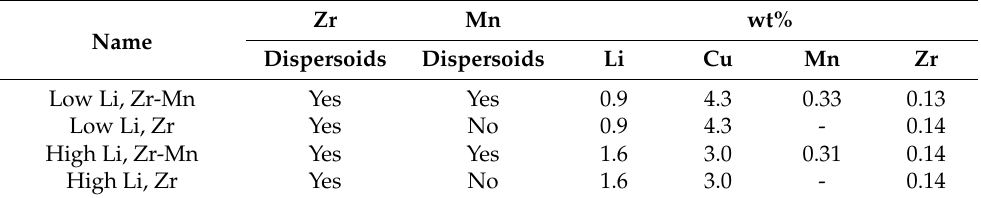
Table 1. Composition of the four samples investigated in the experiments.